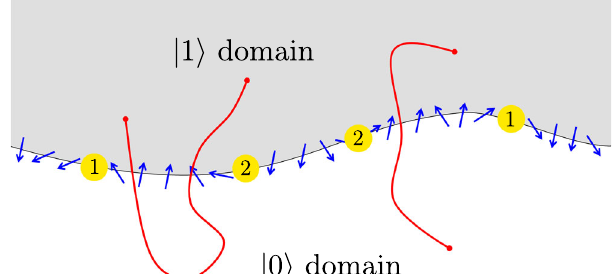
FIG. 11. The fermionic SPT Hamiltonian acts on a Hilbert space with generalized G -spin d.o.f. on vertices and a single FIG. 13. The order in which the fermions are created along the complex fermion d.o.f. for each triangle. Explicitly, the total domain wall is based on the spin structure. Fermions are created C j G j ⊗ Z 2 ð ⊗ Z 2 C 1 j 1 ⊗ Z 2 is a Z Hilbert space is ð ⊗ in pairs — one on either side of the regions for which the 2 p Þ pqr Þ , where p h pqr i interpolating vector field points from j 0 i (white) to j 1 i (gray). graded tensor product. We use γ and ¯ γ as a basis for the pqr pqr These fermions are created left to right if there are an even operator algebra of the complex fermion at h pqr i . number of edges in E (pictured in red) between them and created right to left order otherwise. The ordering is labeled above. Note that, equivalently, the fermions can be ordered from left to right across every j 0 i to j 1 i pointing region as long as a − 1 sign is picked up for each edge in E oriented from j 0 i to j 1 i